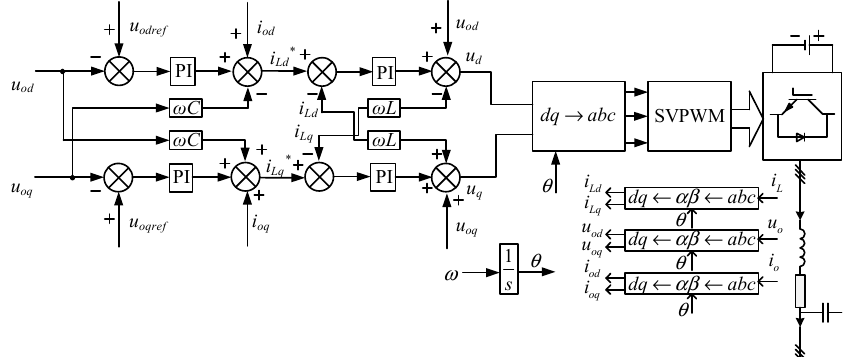
Figure 4. Feedforward dual-loop control block diagram with the decoupling of output voltage and current.